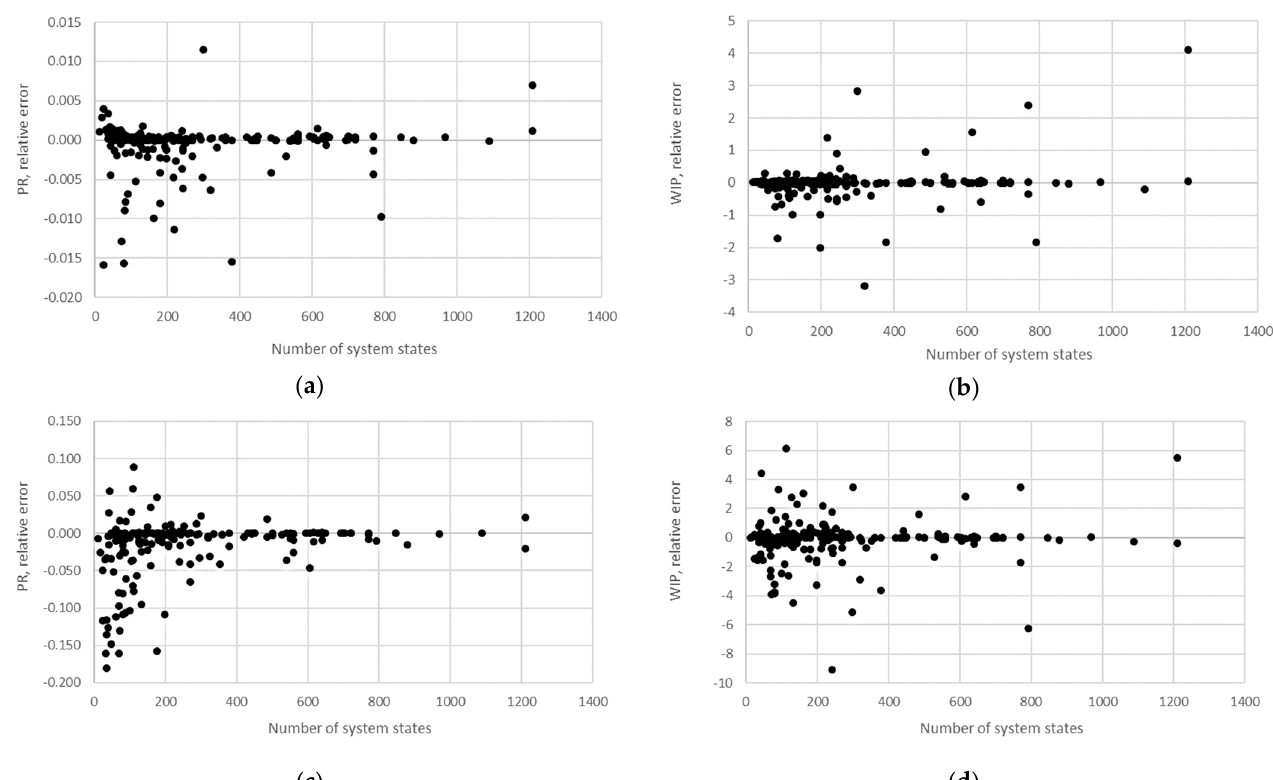
Figure 12. M = 3, relative error obtained using the ( a , b ) AGG procedure and ( c , d ) FSM.